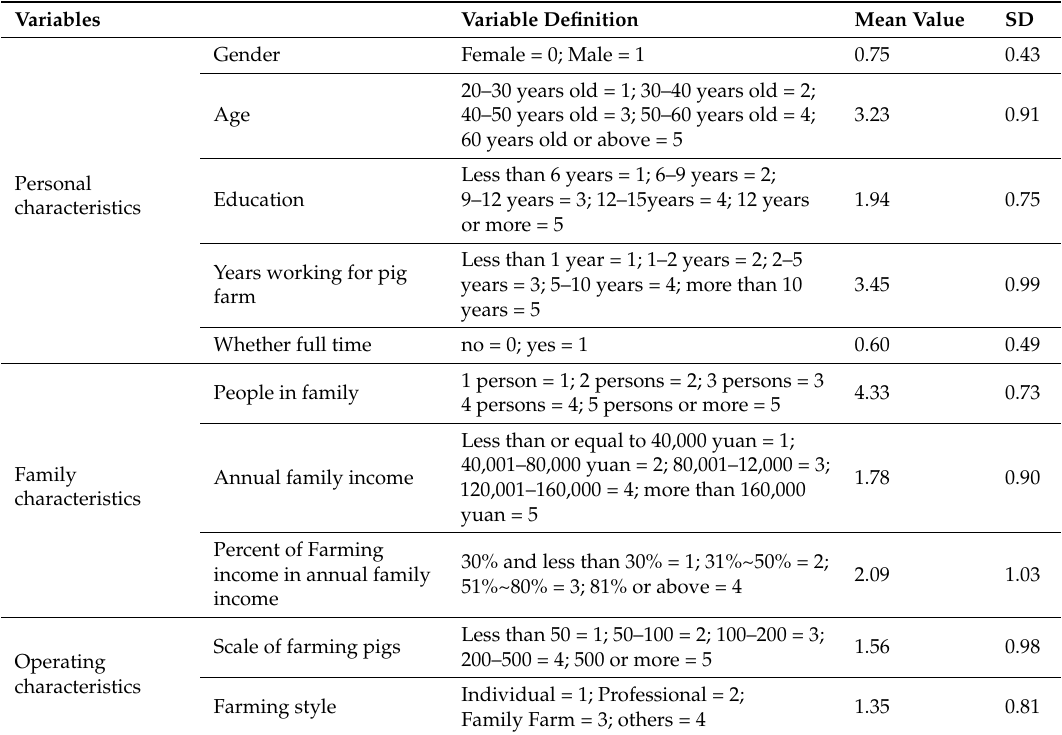
Table 1. Descriptive statistics of control